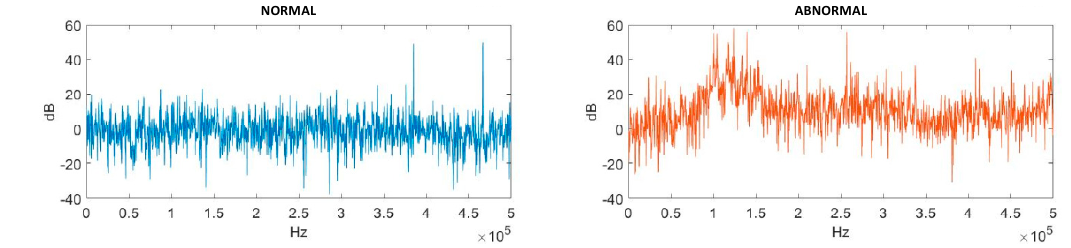
Figure 10. A frame of datasets of the pair (P1, L1).